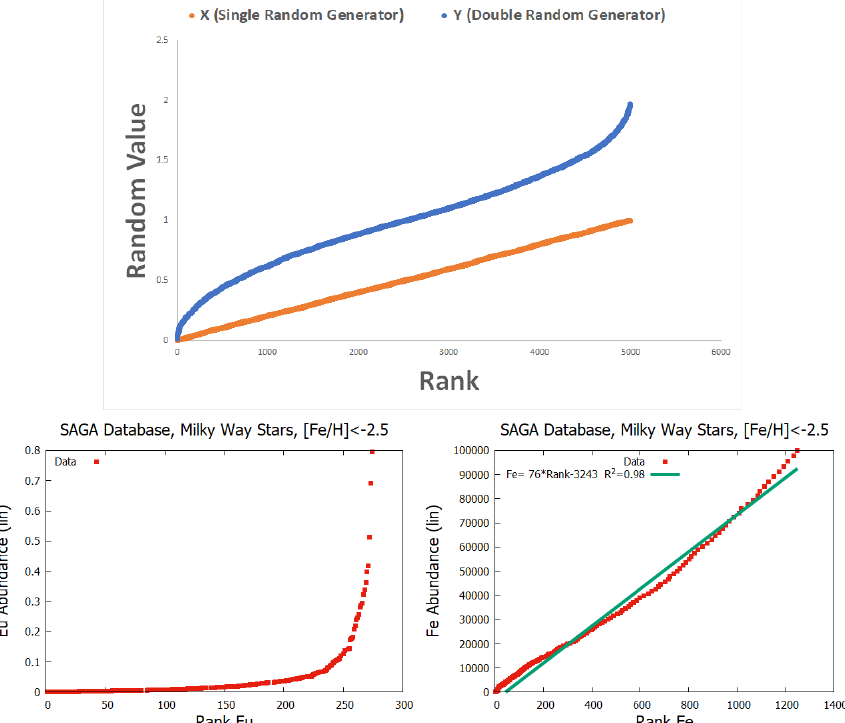
Figure 3. Top: data ordered along their ranks from a single number generator X , showing (a) a linear relation between X -values and their rank, and (b) the sum X 1 + X 2 of two single number generators vs. its rank, deviating from a linear relationship. Bottom left: Eu abundances vs. their rank for low-metallicity stars with [Fe / H] < -2.5, at high ranks (i.e. high Eu abundances) one recognizes an additional / di ff erent strong contribution. Bottom right: The same for Fe abundances, displaying almost a linear relationship, pointing to one identical source, but at low as well as high Fe abundances slight deviations are